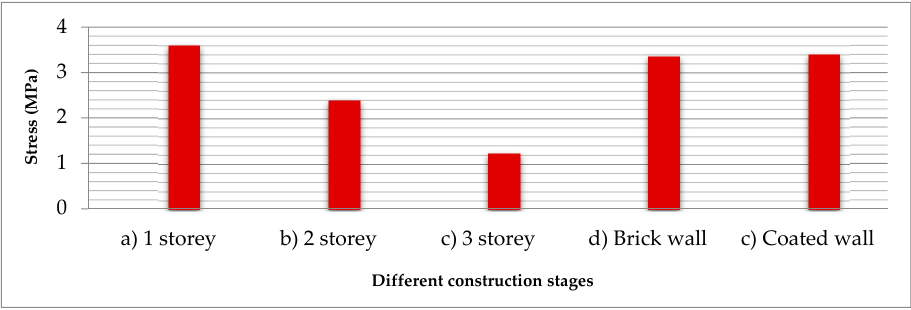
Figure 6. Comparison between maximum principal stresses at different construction stages.